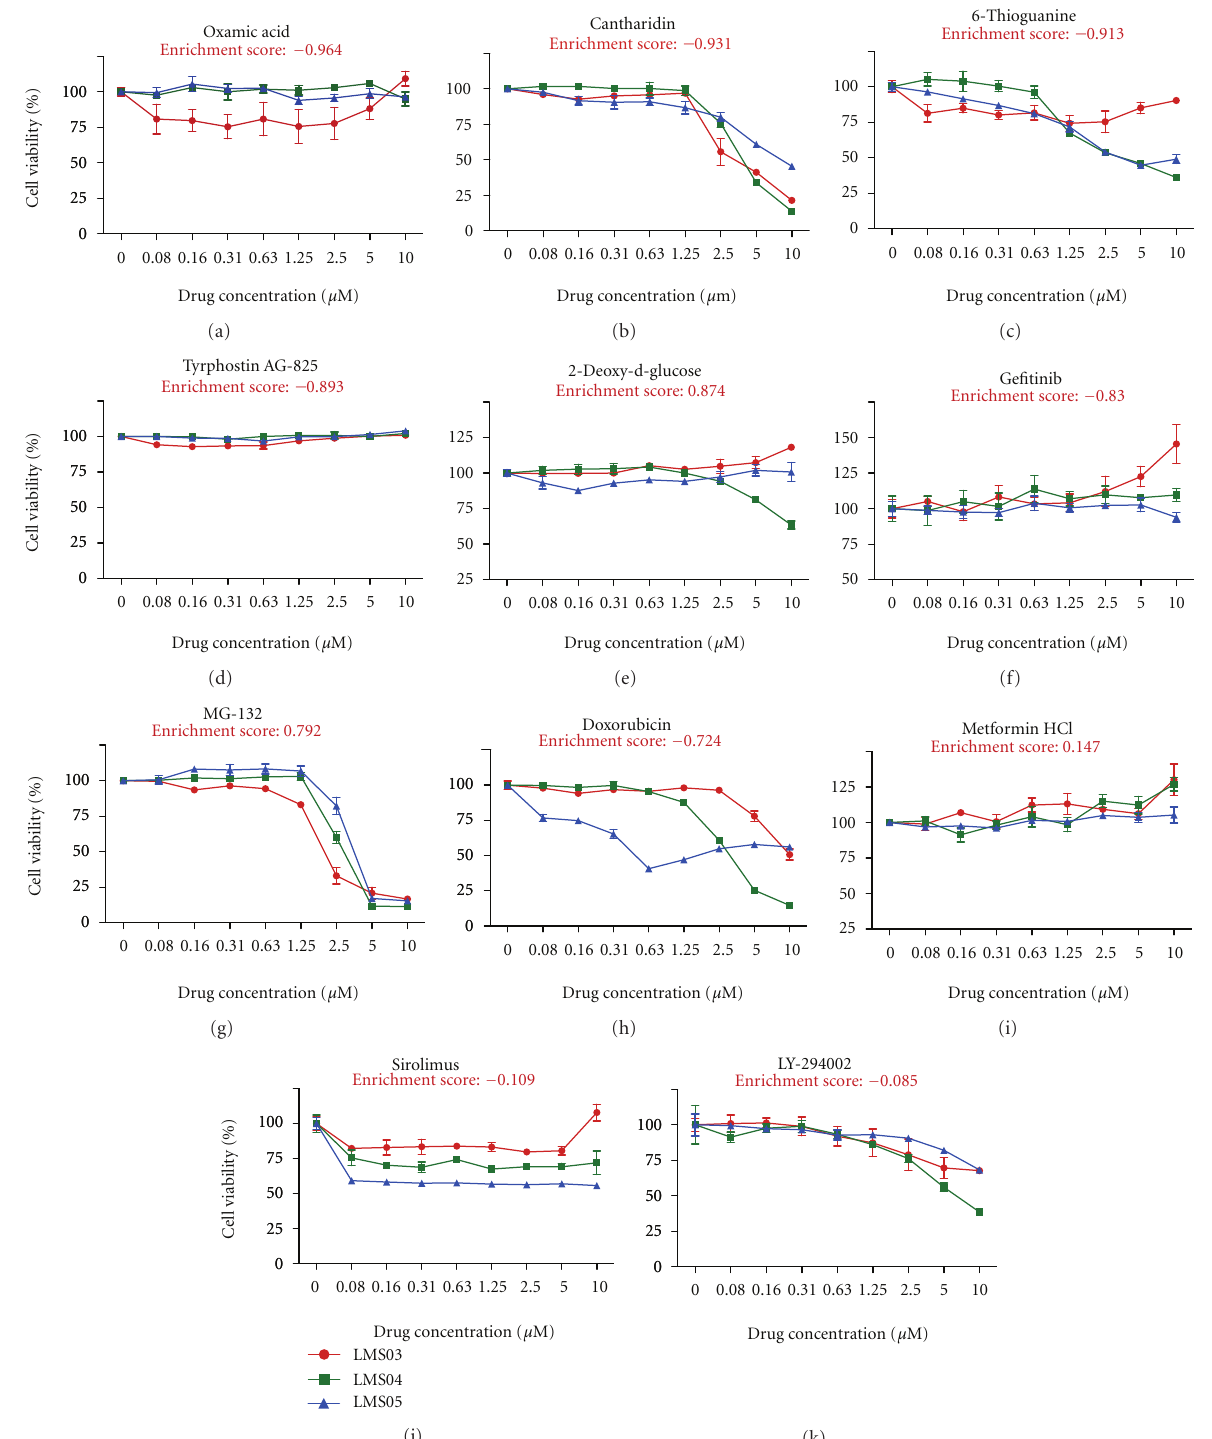
Figure 4: In vitro cell viability assays of 11 drugs on three LMS cell lines. Three LMS cell lines, LMS03, LMS04, and LMS05, were exposed to the indicated drugs at concentrations ranging from 0 to10 μ M. Cell viability was assessed 72h after exposure to drugs using WST-1 assays and experiments were performed in triplicate. Data are arranged in order of decreasing magnitude of cmap enrichment scores for LMS Subtype II, which all three cell lines most closely resembled according to our